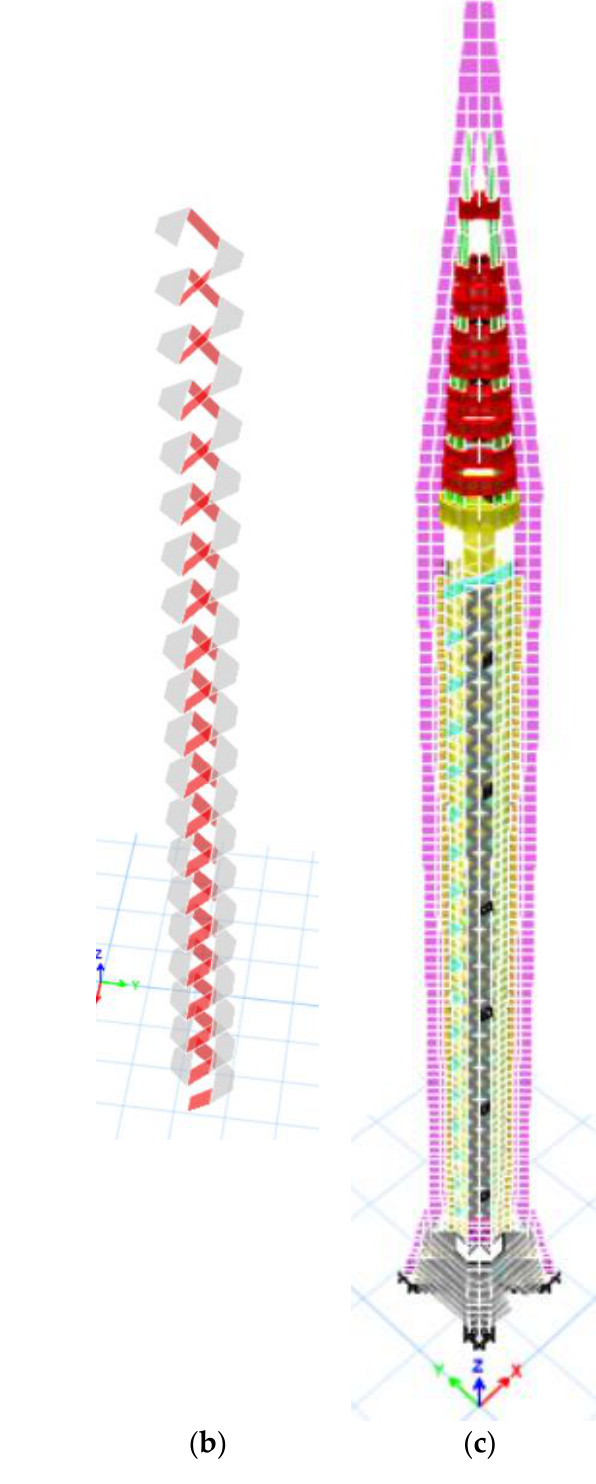
Figure 11. The FE model of the minaret ( a ) plan, ( b ) stairs, and ( c ) 3D view.